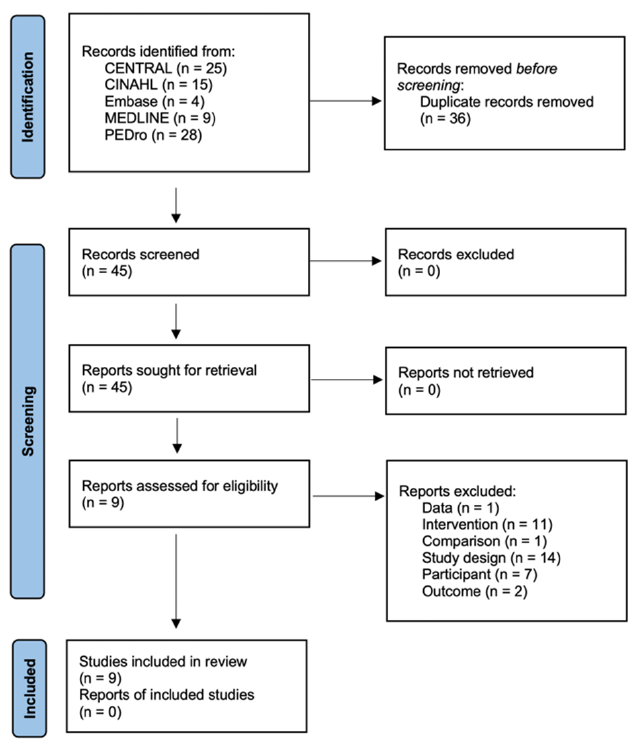
Figure 1. PRISMA flow diagram.